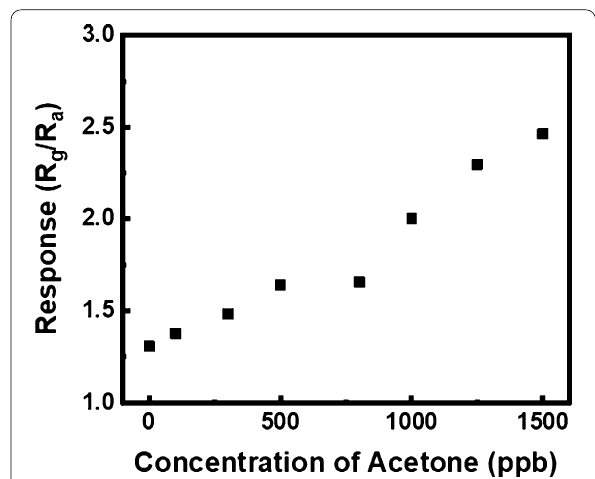
Fig. 6 Response of ZnO–CuO hollow nanocubes as a function of acetone concentration